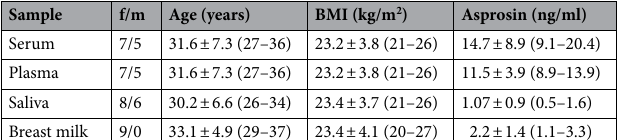
Table 1. Ranges of determined asprosin concentrations (mean ± SD) in various body fluids.